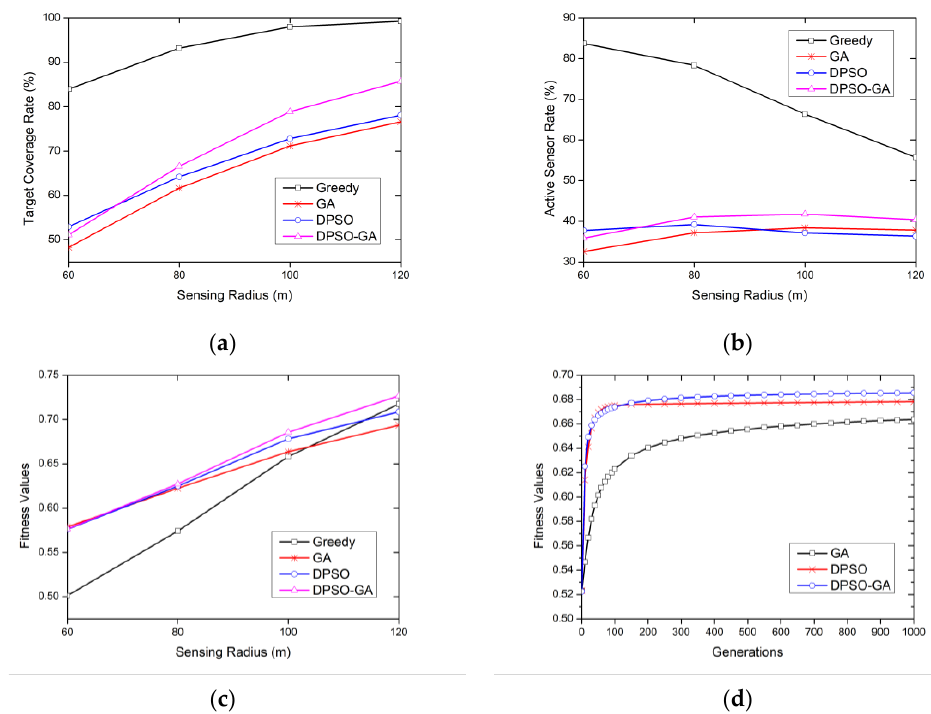
Figure 7. Effect of the sensing radius on the target coverage rate, active sensor rate, and fitness val- ues under greedy, GA, DPSO, and DPSO_GA algorithms. ( a ) Target coverage rate, ( b ) active sensor rate, ( c ) fitness values, and ( d ) fitness values versus the number of generations for the GA, DPSO, and DPSO_GA algorithms.